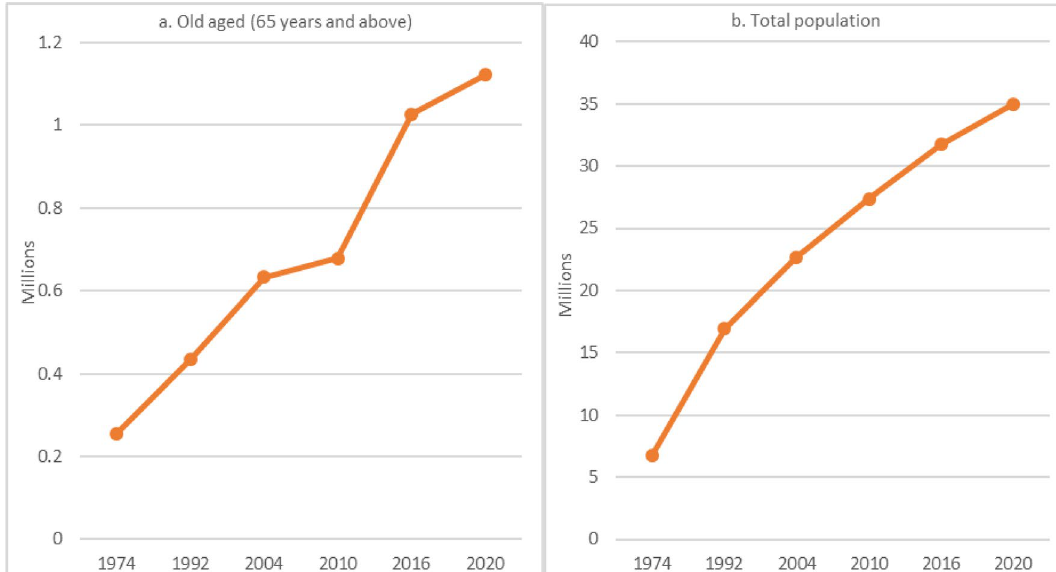
Figure 1. Growth of old aged versus total population.